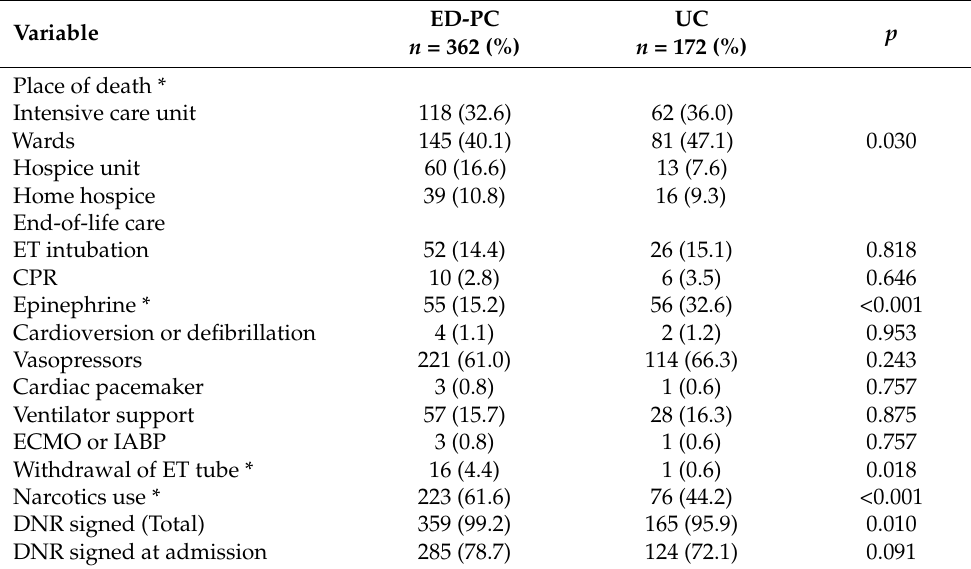
Table 4 compared the end-of-life care in hospitalization between patients with mor- tality under palliative care and usual care. It was observed that more palliative care patients died in the hospice unit (16.6% vs. 7.6%), fewer in the ICU (32.6% vs. 36.0%), and fewer in ordinary wards (40.1% vs. 47.1%, p = 0.030). Palliative care patients received less epinephrine (15.5% vs. 32.6%, p < 0.001), more cases with withdrawal of the endo- tracheal tube (4.4% vs. 0.6%, p = 0.018), and more administration of narcotics (61.6% vs. 44.2%, p < 0.001). There was no significant difference in the endotracheal intubation, CPR, cardioversion or defibrillation, vasopressors, cardiac pacemaker, ventilator support, and extracorporeal membrane oxygenation (ECMO) or intra-aortic balloon pump (IABP). The patients with mortality under palliative care had higher DNR orders compared to usual care (99.2% vs. 95.9%, p = 0.010). There was no significant difference in the numbers of DNR signed at admission between palliative care and usual care patients with mortality (78.7% vs. 72.1%, p = 0.091). Table 4. Comparison of the end-of-life care in hospitalization between 362 ED-PC patients with mortality and 172 UC patients with mortality. ED-PC UC Variable n = 362 (%) n = 172 (%)